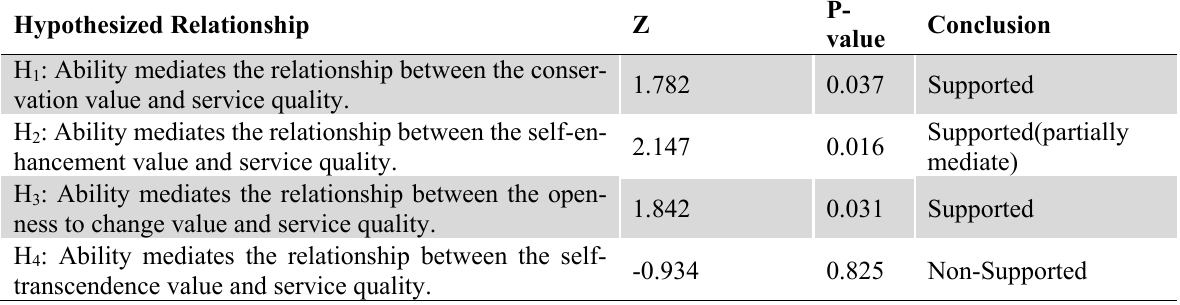
Hypothesis testing Hypothesized